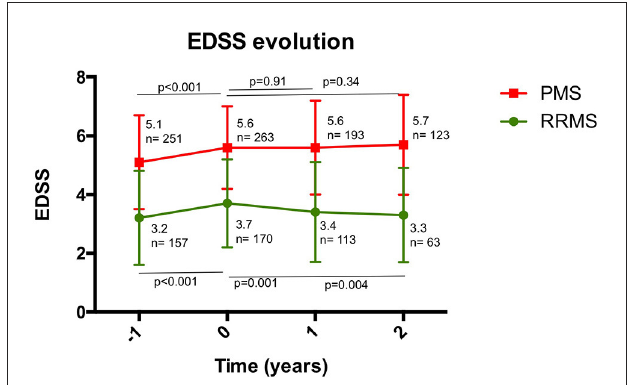
FIGURE3 Disability measured by EDSS, before and after the first and second year after starting rituximab. A significant increase in EDSS was observed the year before starting rituximab. For RRMS, a significant decrease in EDSS was observed after the first year of treatment, which was maintained during the second year. For PMS, EDSS remained stable for 2 years after starting rituximab. PMS, progressive multiple sclerosis; RRMS, relapsing-remitting multiple sclerosis.